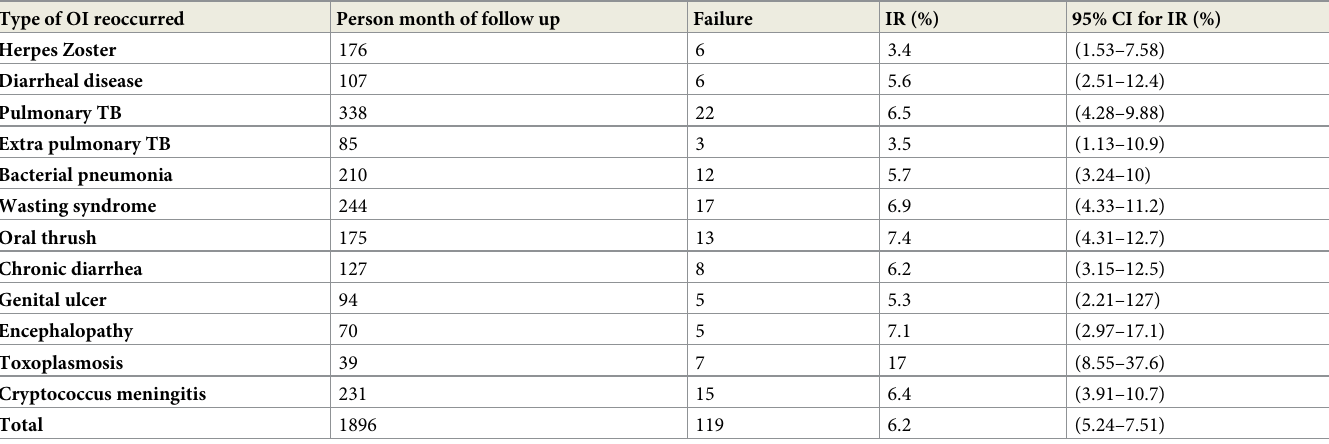
Table 2. Types of OI reoccurred among cohort of HIV/AIDS patient attending ART at public health facility in Arba Minch Town,